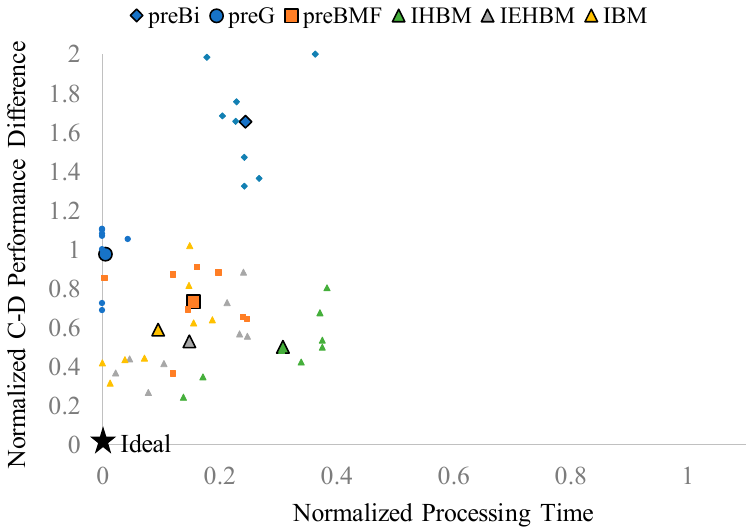
Figure 5. Compression–Denoising–Time Performance.